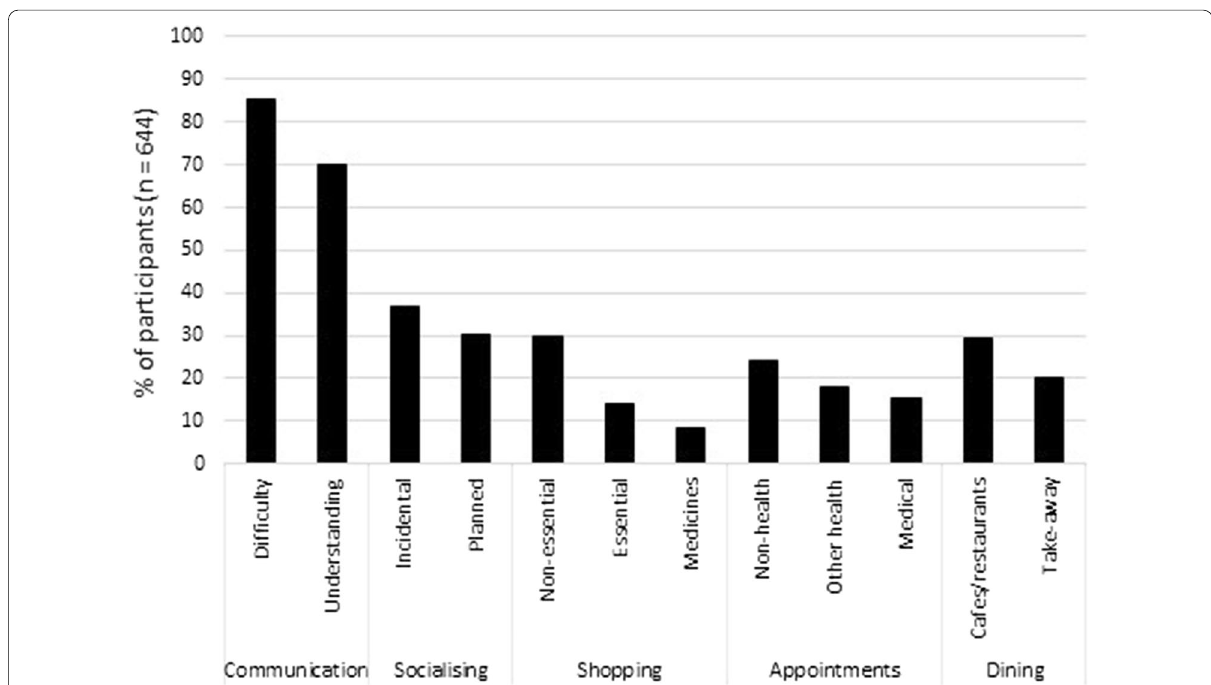
Fig. 6 Percentage of the total group of participants who reported communicating with other people wearing face masks in the community ( n 644) who reported a worsened outcome in selected aspects of communication, and decreased participation in selected =